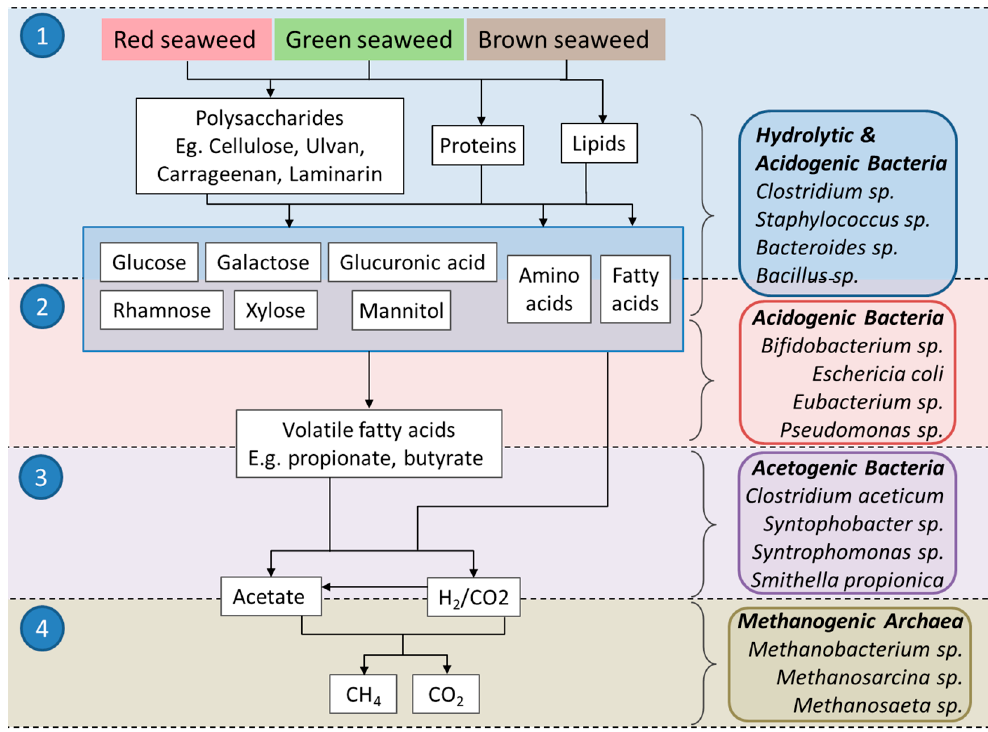
Figure 1. A simplified schematic of the processes and microorganisms involved during AD. Numbered circles represent the stages of AD: (1) hydrolysis, (2) acidogenesis, (3) acetogenesis, (4) methanogenesis. Examples of bacteria and archaea involved in these stages [9] are shown on the right-hand side of the diagram. Schematic adapted from [17] Maneein et al. (2019).